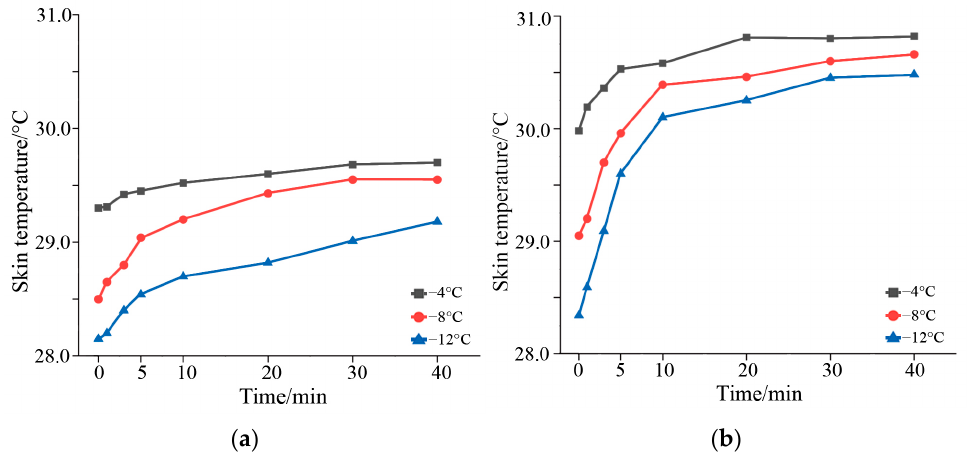
Figure 8. Skin temperature. ( a ) Low activity; ( b ) high activity.